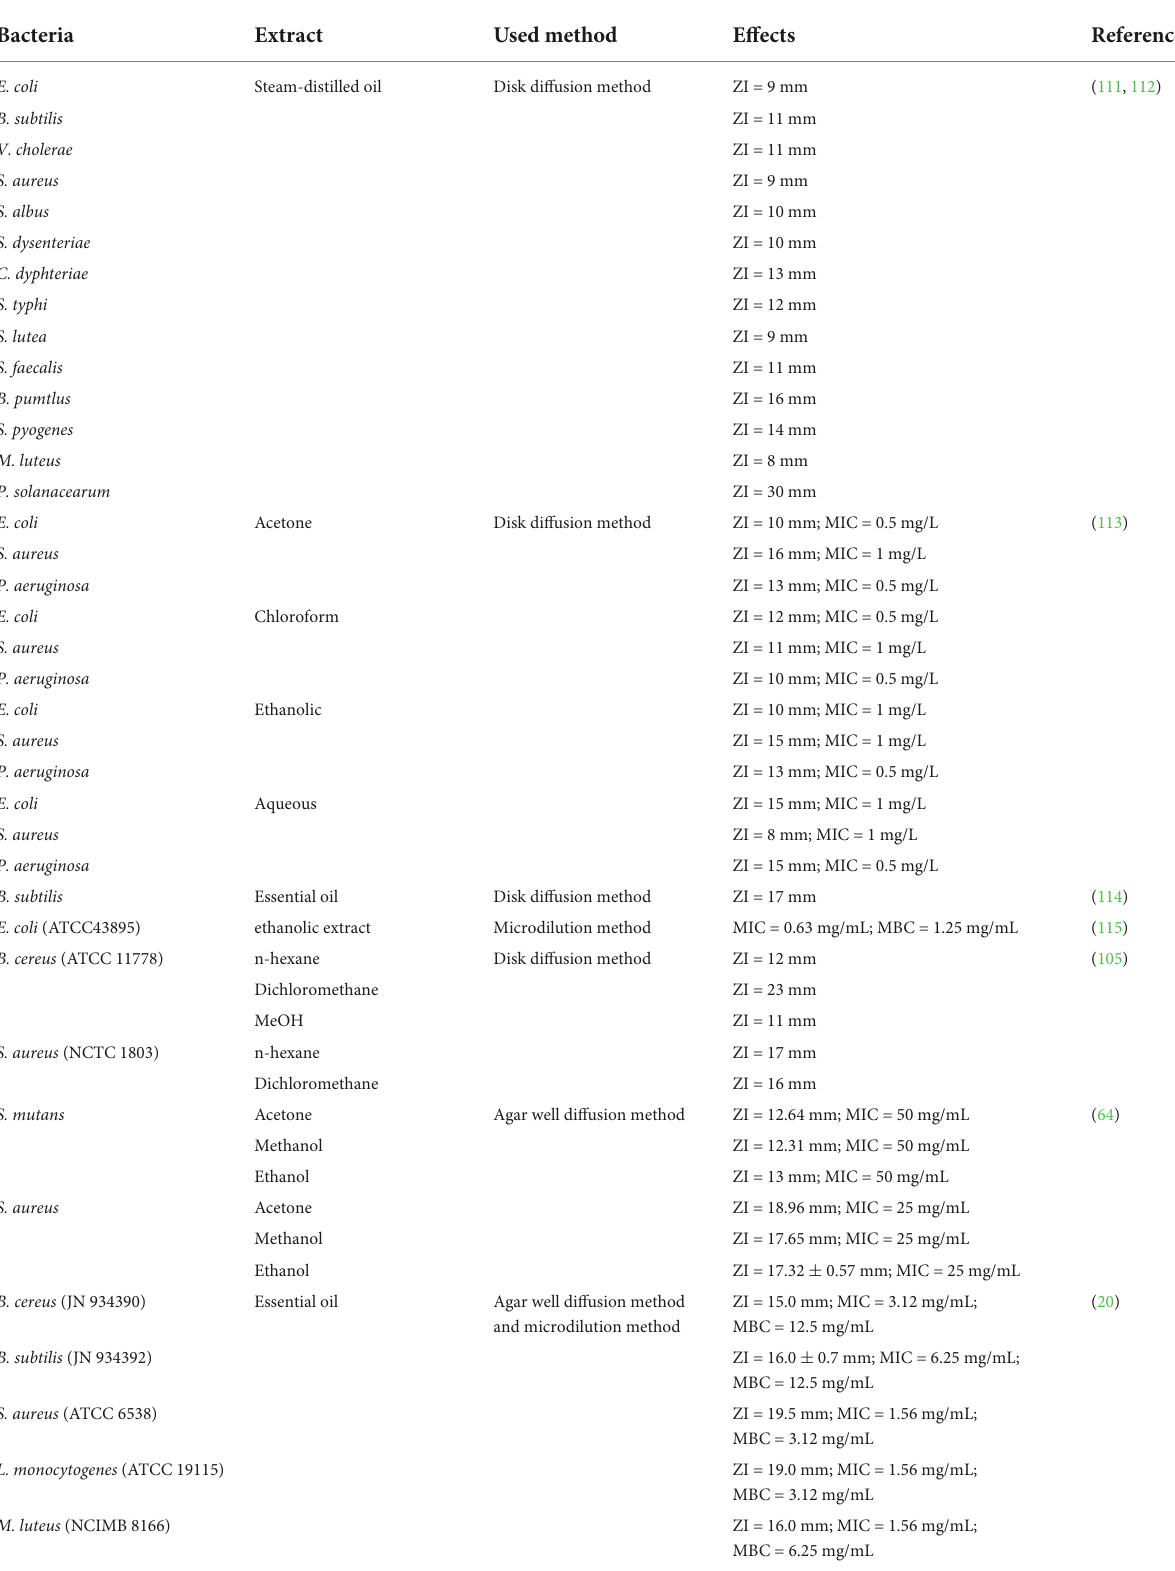
TABLE 5 Antibacterial activity of P. cubeba. Bacteria Extract Used method